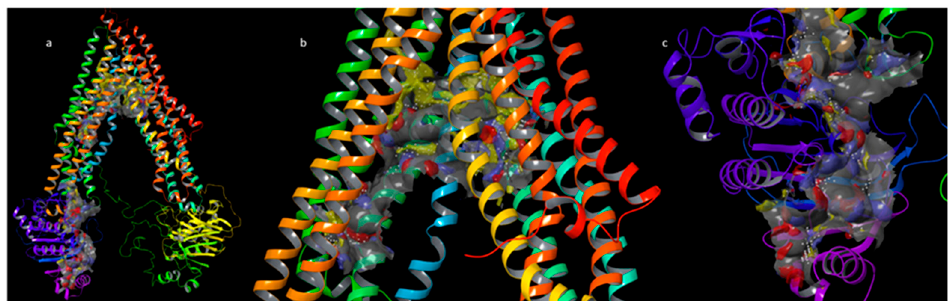
Figure 4. ( a ) DBP and NBP retrieved by SiteMap analysis; ( b ) point of view of DBP; ( c ) point of view of NBP. The phobic surfaces are reported in yellow, the HB acceptor surfaces are reported in red, HB donor surfaces are reported in blue, the surfaces of the two pockets are reported in grey.